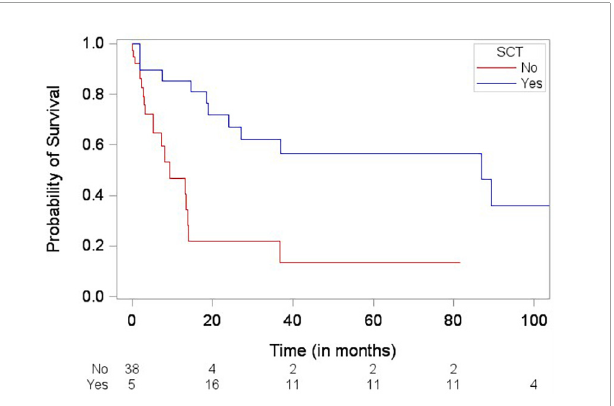
FIGURE4 Simon and Makuch plot demonstrating stem cell transplantation (SCT) being significantly associated with decreased risk of death ( p -value = 0.0012) based on Cox regression analysis with SCT as a time-varying